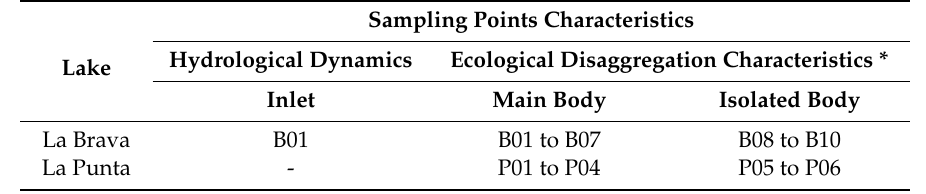
Table 1. Characteristics of the hydrological and ecological dynamics of the La Brava-La Punta lake system and establishment of sampling